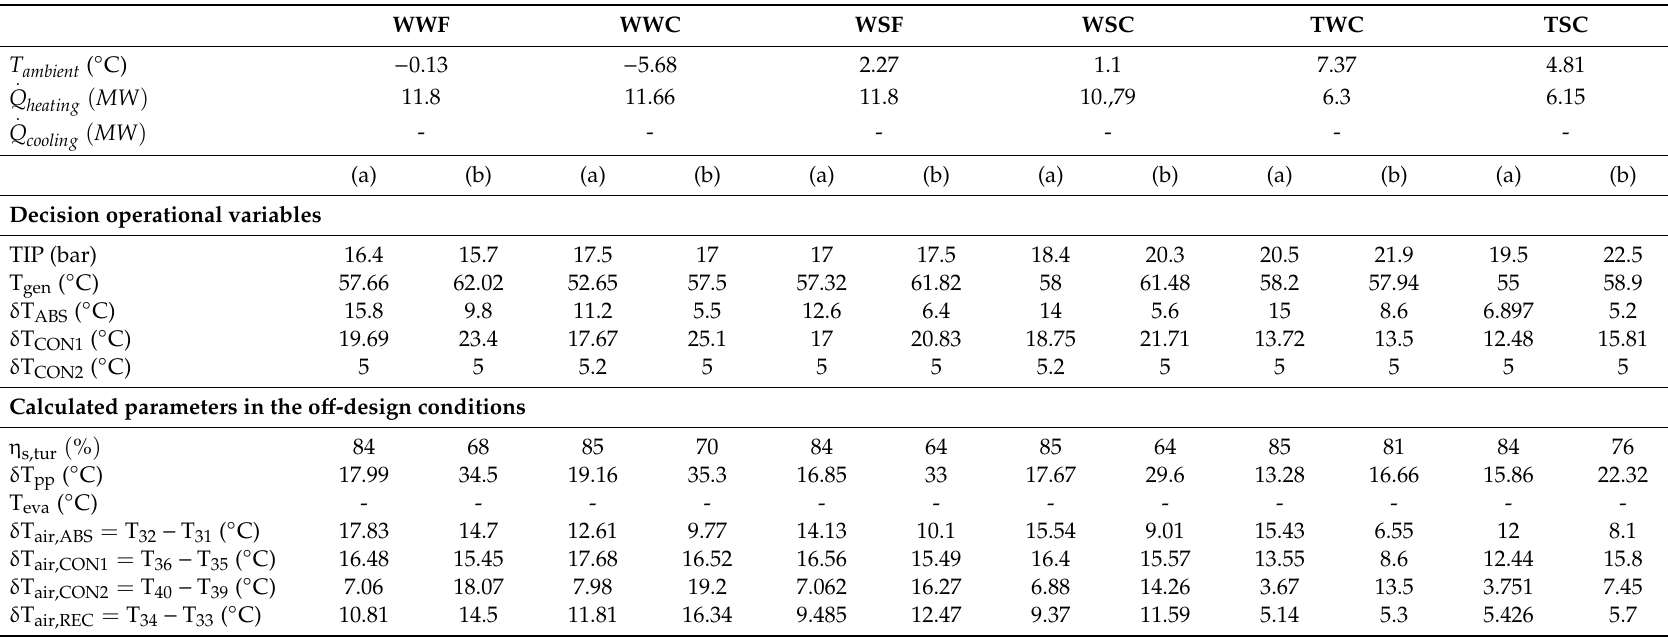
Table A1. Detailed parameters of the optimization calculation (a) maximum exergy e ffi ciency (b) minimum exergy.destruction